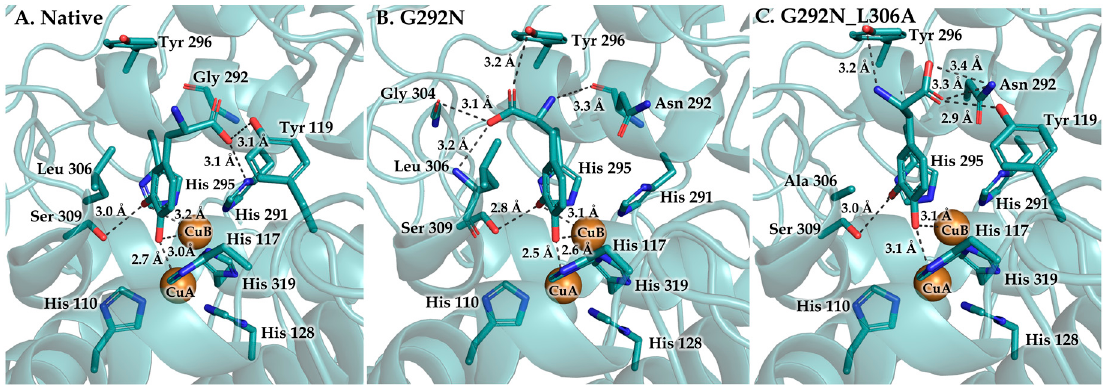
Figure 1. Docking poses of L-DOPA in ( A ) Native Tt PPO, ( B ) variants G292N and variant G292N_L306A ( C